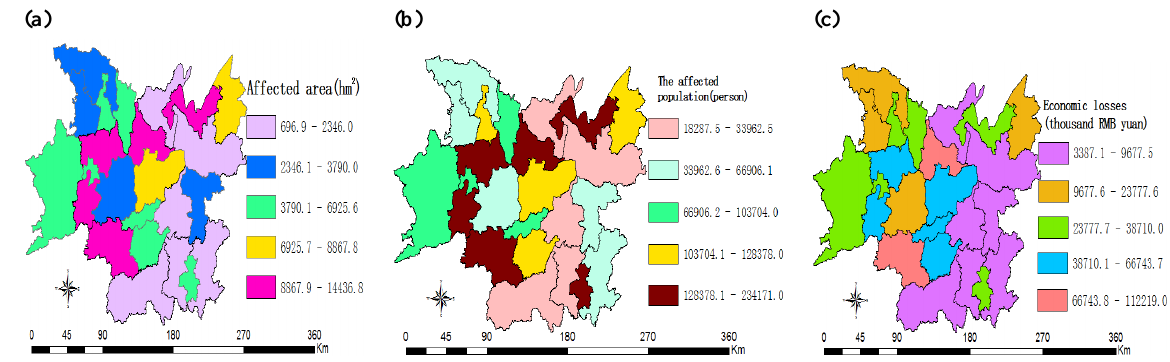
Fig.6. The economic density (left panel) and population density (right panel) in Dongting Lake region